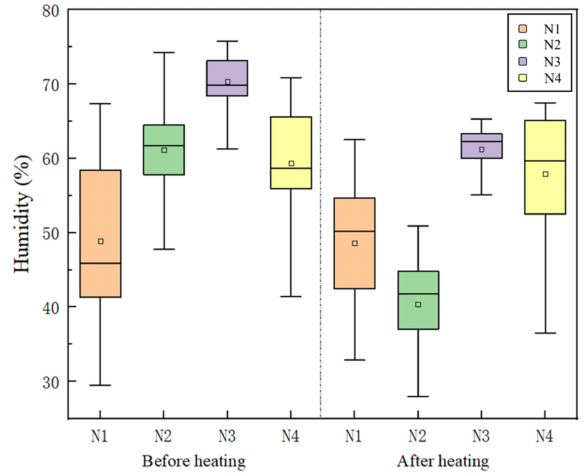
Figure 7. Box diagram of